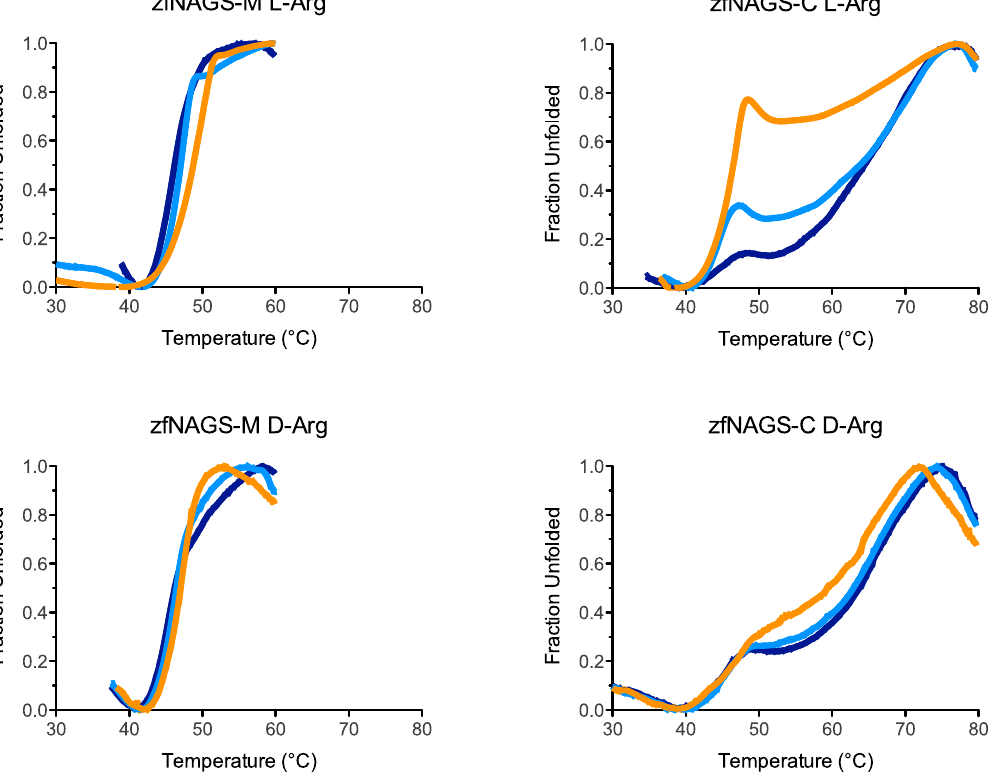
Figure 7. Thermofluor H analysis of zebrafish NAGS in the presence and absence of L- and D-arginine. Unfolding of zfNAGS-M was measured in the presence of increasing concentrations of either L-arginine (A) or D-arginine (B). Unfolding of zfNAGS-C was measured in the presence of increasing concentrations of either L-arginine (C) or D-arginine (D). Dark blue – thermal unfolding in the absence of L- or D-arginine. Cyan - thermal unfolding in the presence of 1 mM L- or D-arginine. Orange - thermal unfolding in the presence of 10 mM L- or D-arginine.